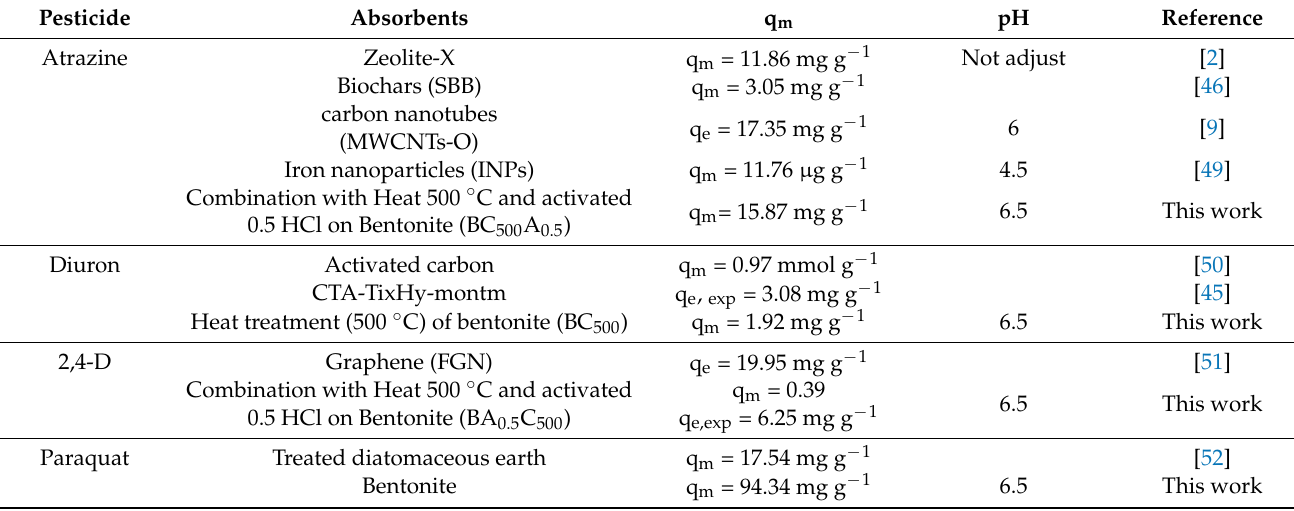
Table 13. Comparison of q m values from the Langmuir isotherm model of adsorbents and modified adsorbents for the removal of